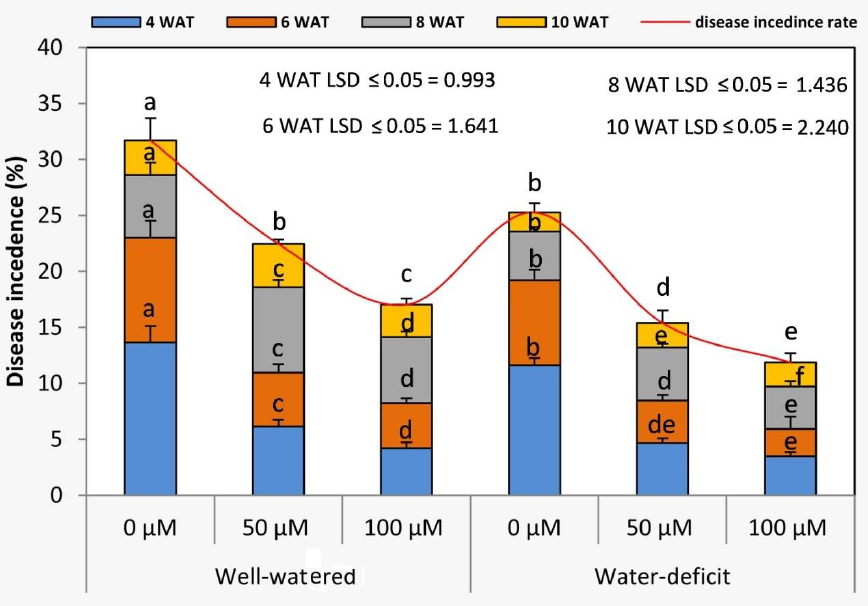
Figure 6. Effects of SNP as foliar applications at 0, 50, and 100 µ M on viral disease incidence of tomato plants. In each variable, data followed by the same letters are not significantly different using the LSD multiple rang test at a 5% level. WAT: weeks after transplanting.